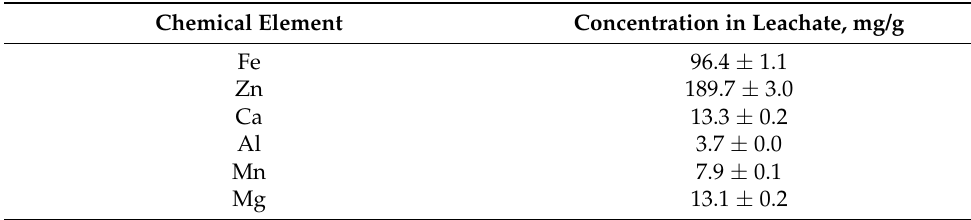
Figure 3. Zinc recovery rate of 0.125, 0.25, 0.5, and 1 molar solutions of sulfuric acid at different times during leaching process with electric furnace dusts. Table 3. Concentration in leachate of zinc and chemical elements potentially detrimental to devel- opment of hydrometallurgical techniques in a 1 molar sulfuric acid solution and a leaching time of 36